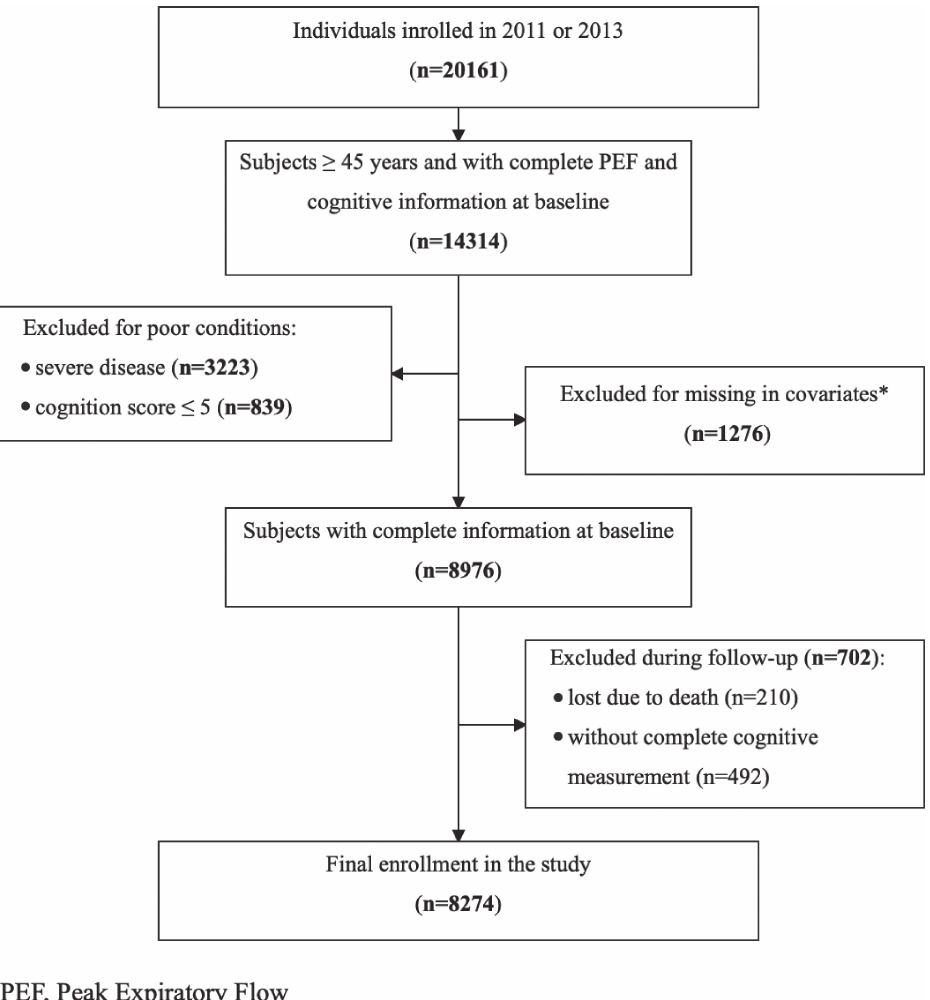
Fig. 1 Flowchart of the study subjects in the study * Age: 79 missings; residence: 1 missing; marital status: 1 missing; education: 1096 missings; health insurance: 26 missings; smoking: 418 missings; alcohol use: 7 missings; height: 68 missings; weight: 77 missings; hypertension: 12 missings; diabetes: 26 missings; dyslipidemia: 50